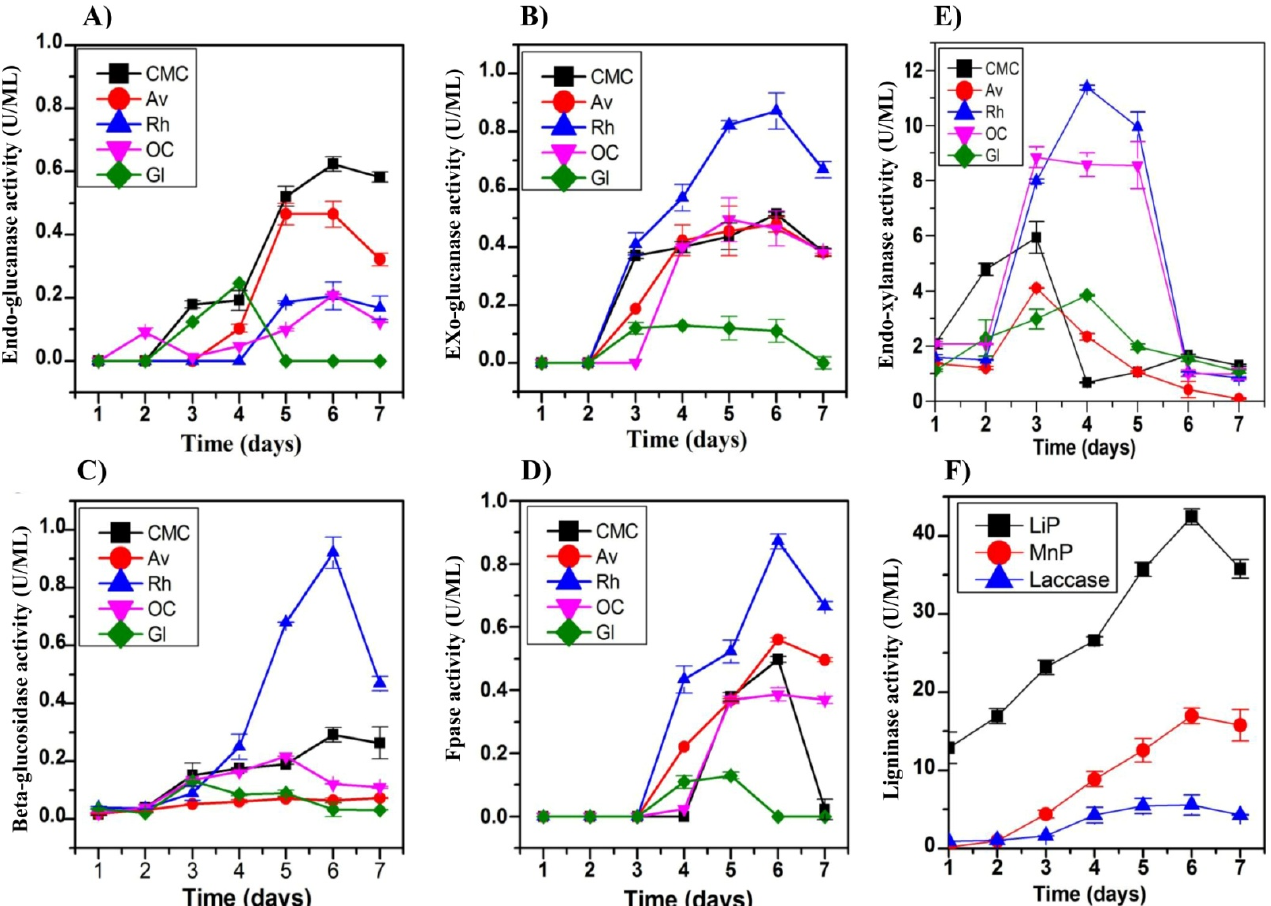
Figure 5. Activities of extracellular lignocellulolytic enzymes of Colletotrichum sp. OH, in the presence of different carbon sources. Time-series plots of endoglucanase ( A ), exoglucanase ( B ), β -glucosidase ( C ), Fpase ( D ), and endoxylanase ( E ) production by OH on different carbon sources. ( F ) Changes in ligninase activities, such as Lac, laccase; MnP, manganese peroxidase; and Lip, lignin peroxidase, in the presence of rice husk as detected by the colorimetric assay. Experiments were performed in triplicate, and the heights of the bars and the error bars indicate the means ± standard error mean (SEM).